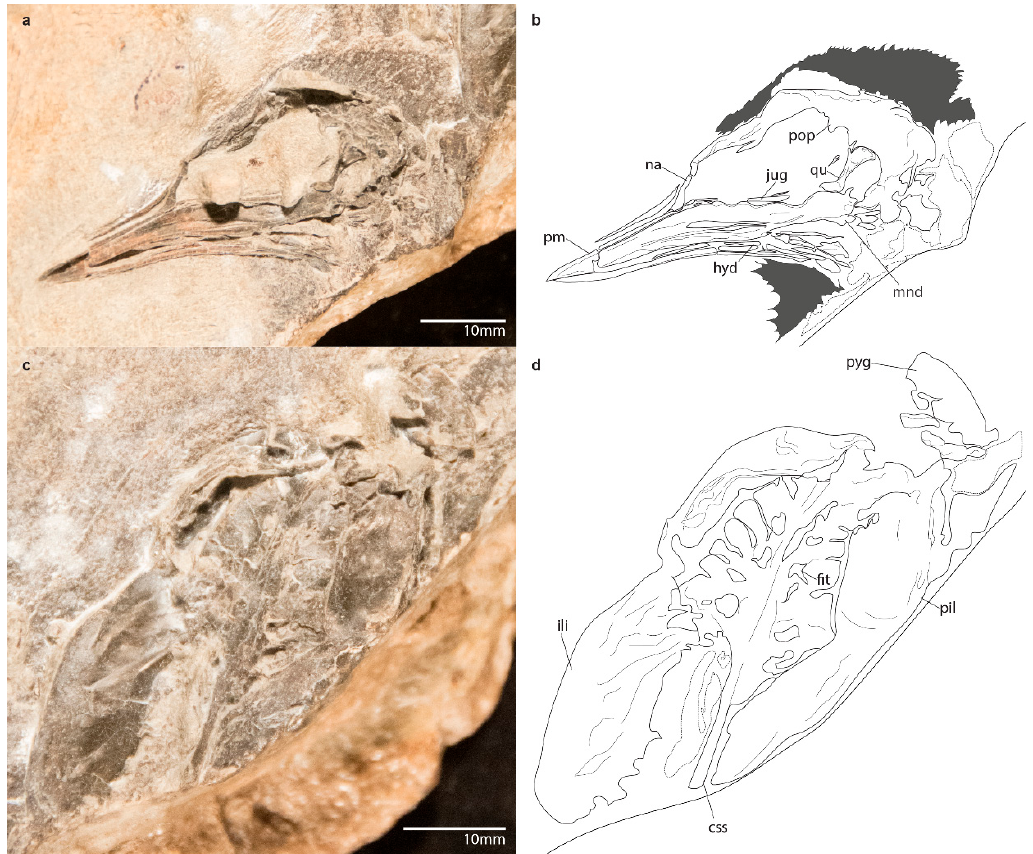
Figure 2. Photographs ( a , skull in lateral aspect and c, pelvis in dorsal aspect) and line drawings ( b , d) of the holotype specimen of Pellornis mikkelseni , MGUH 29278. Soft tissue and plumage is filled in with gray. Dashed borders indicate bone that is extremely broken. Anatomical abbreviations: pm premaxilla, na narial bar, pop postorbital process, pal palatines, qu quadrate, jug jugal, mnd mandible, hyd hyoids, ili preacetabular ilium, pil postacetabular ilium, fit foramen intertransversarium, pyg pygostyle.